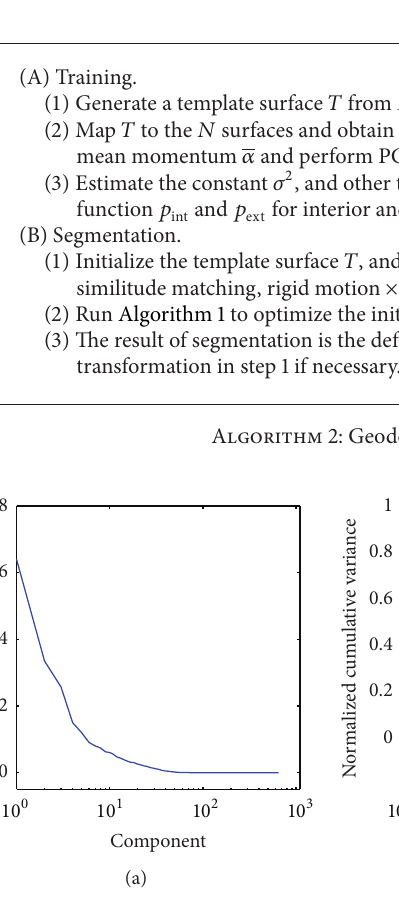
Figure 2: (a) The variance of each PCA coefficient in the left hippocampus ADNI population. (b) The normalized cumulative variance indicating the number of dimensions accounting for 95% of the variability. Note the semilog scale in (a) and (b). (c) A scatter plot of the first two PCA coefficients for this